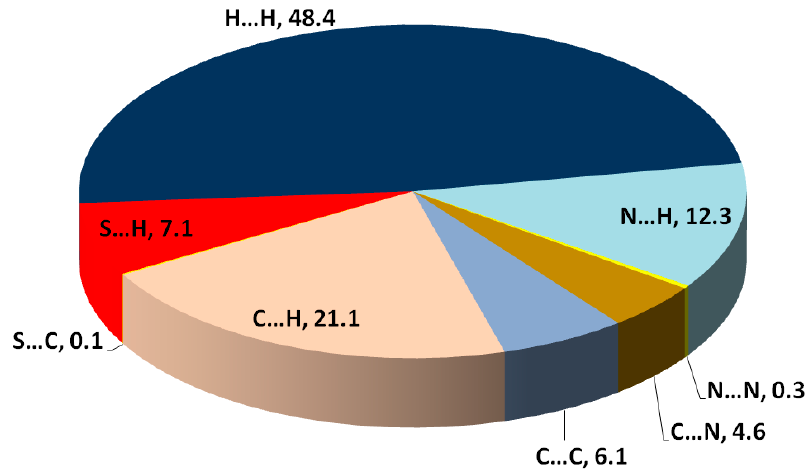
Figure 3. Summary of the intermolecular interactions contributed in the molecular packing of 2 and their percentages.